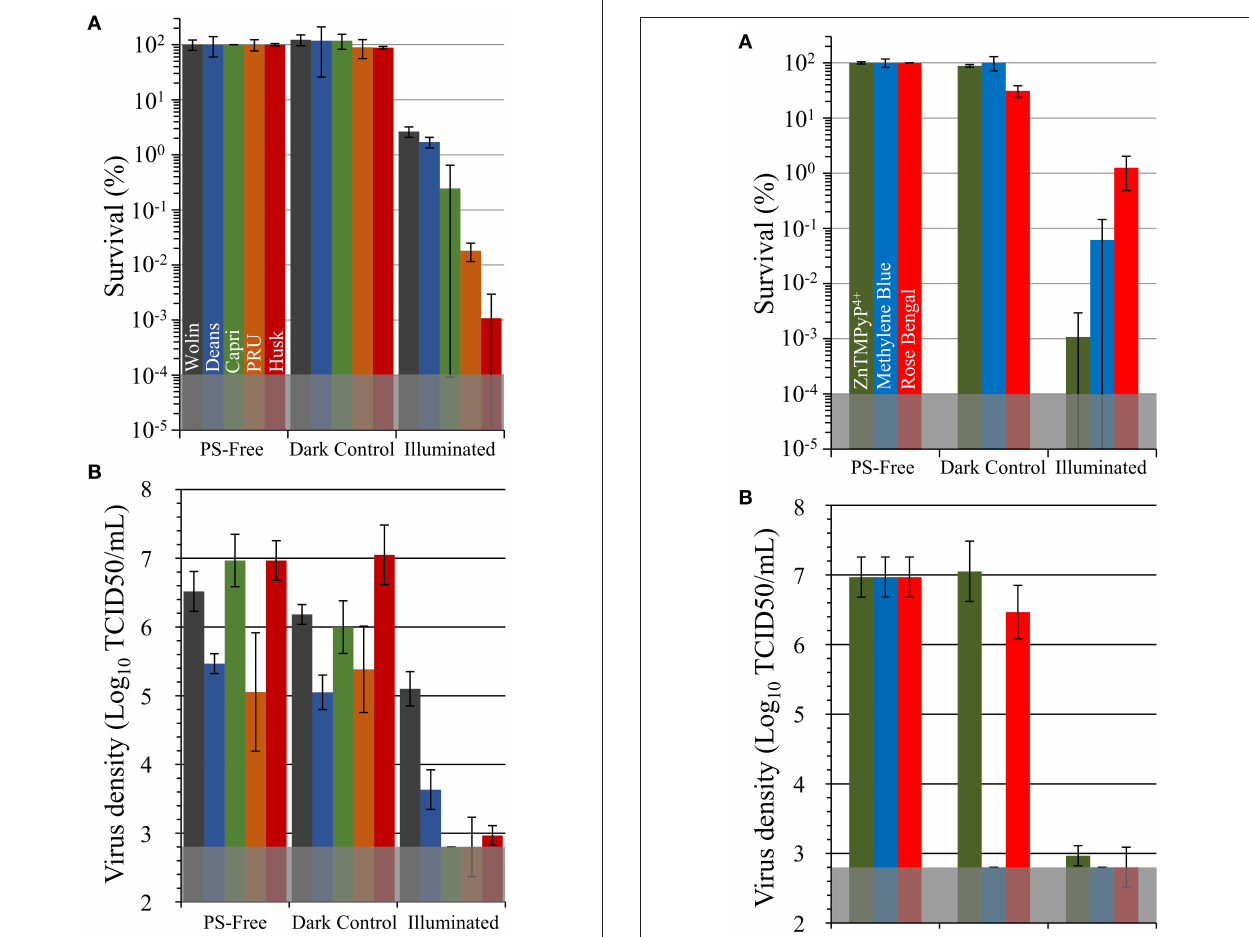
FIGURE 7 | Antimicrobial photodynamic inactivation efficacy of Vescom materials coated with SbQ-PVA/MB and SbQ-PVA/RB for (A) methicillin-susceptible S. aureus ATCC-29213 (MSSA) and (B) human coronavirus 229E (HCoV-229E). Experimental conditions were the same as those listed in Figure 6 . The results for SbQ-PVA/ZnTMPyP 4 + are included for ease of